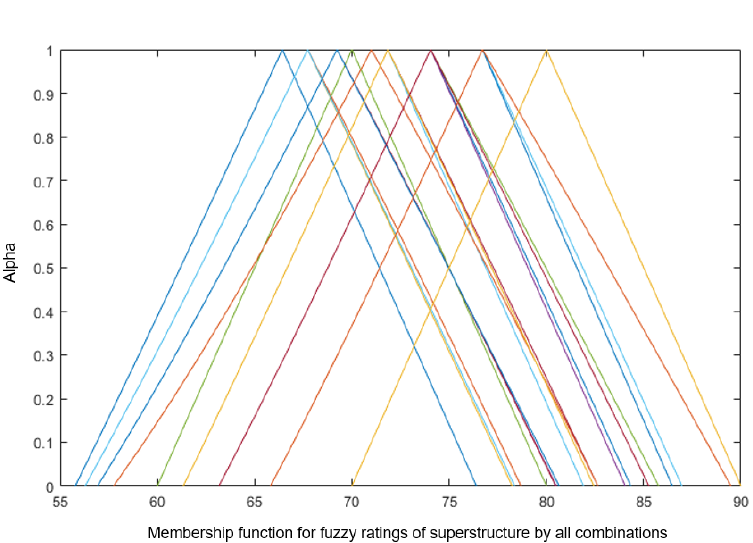
Figure 6. Graphical representation of the superstructure component rating values for all combinations.